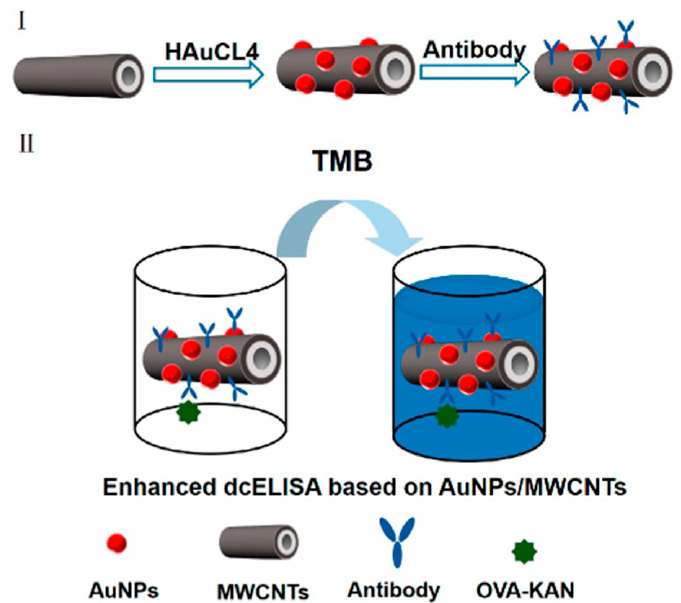
Figure 2. Schematic diagram of direct competitive enzyme-linked immunosorbent assay (dc-ELISA) based on Au/multiwalled carbon nanotubes (MWCNT). ( I ) Preparation of antibody labeled AuNPs/ MWCNTs nanohybrids; ( II ) Development of enhanced dcELISA based on AuNPs/MWCNTs [86] (reproduced with permission from John Wiley and Sons, Inc.).